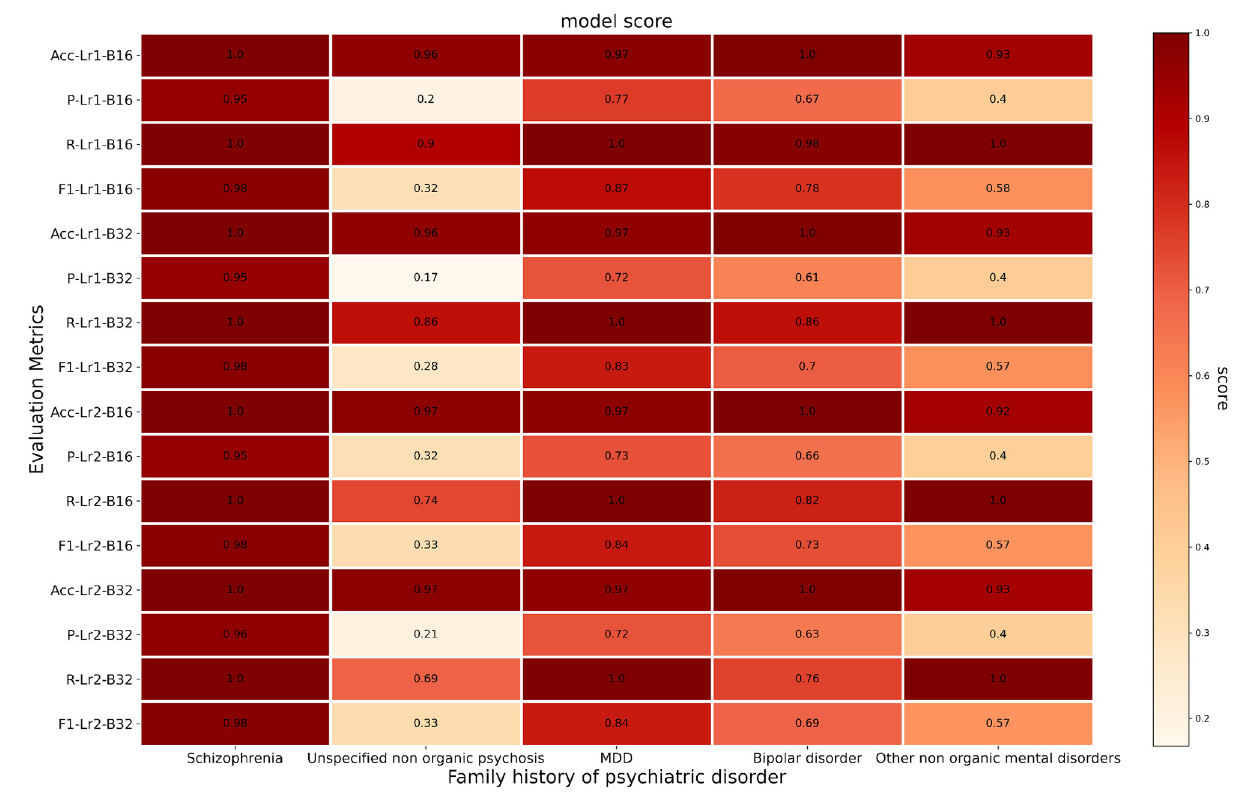
Frontiers in Psychiatry |